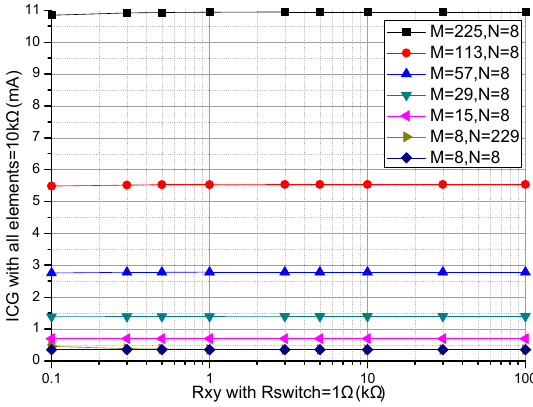
Figure 8. Effect of array size on the I CG of the improved circuit.